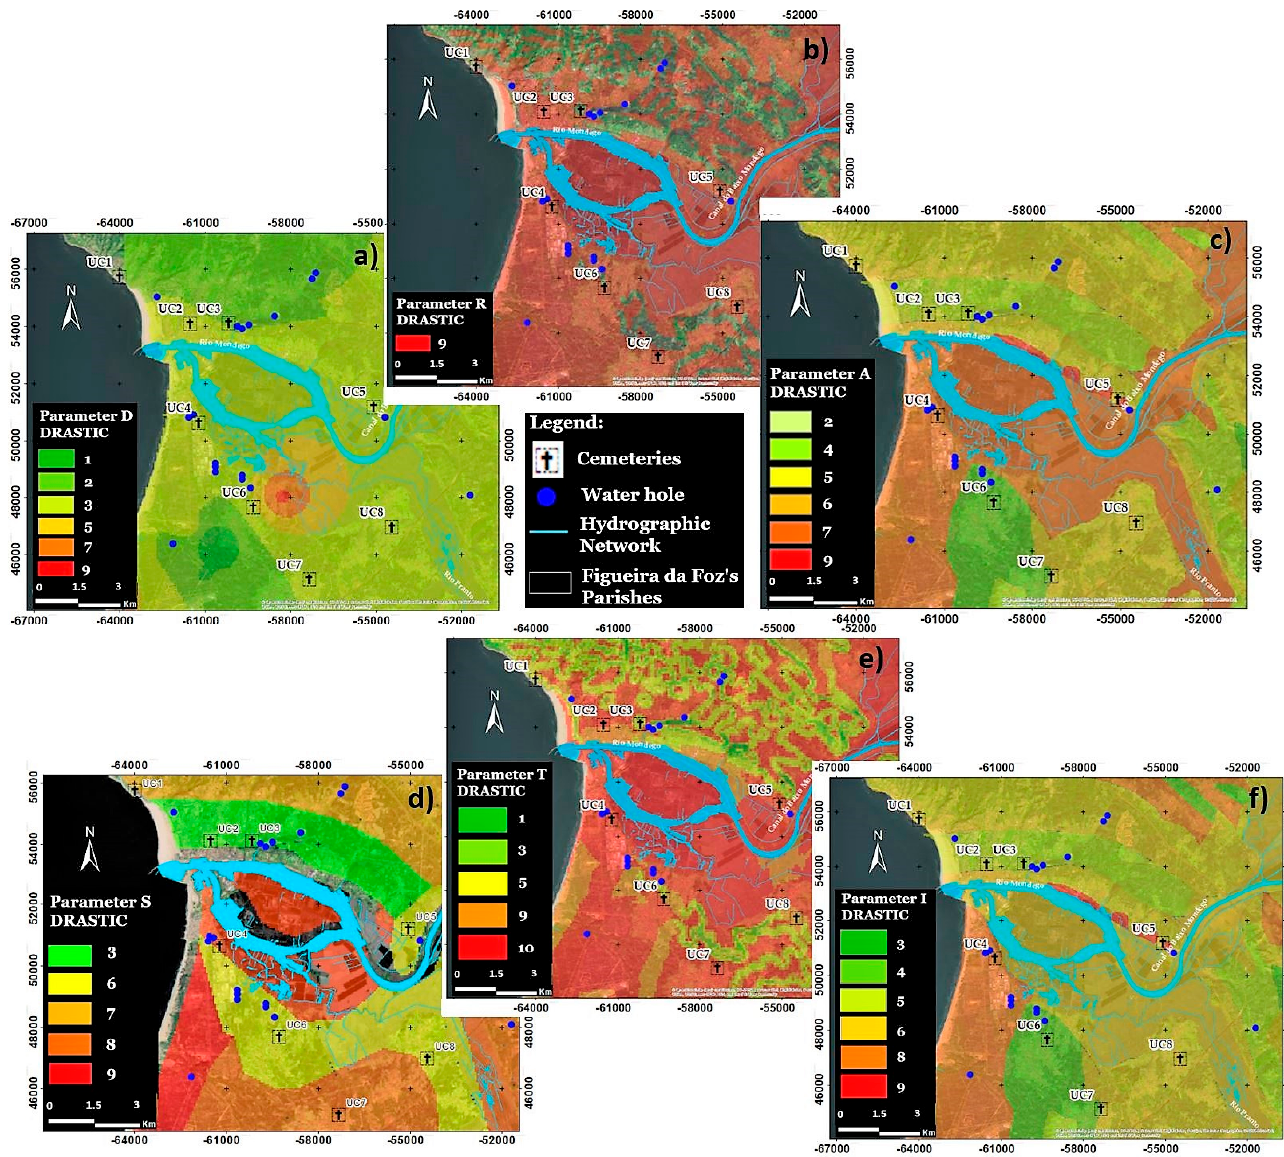
Figure 9. a ) Parameter D map; b ) parameter R map; c ) parameter A map; d ) parameter S map; e ) Figure 9. ( a ) Parameter D map; ( b ) parameter R map; ( c ) parameter A map; ( d ) parameter S map; parameter T map; f ) parameter I map of the studied area. ( e ) parameter T map; ( f ) parameter I map of the studied